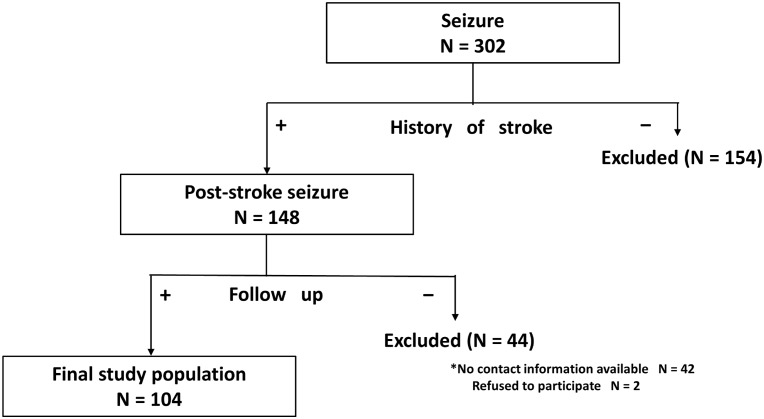
Study design and protocol.PSS, post-stroke seizures.